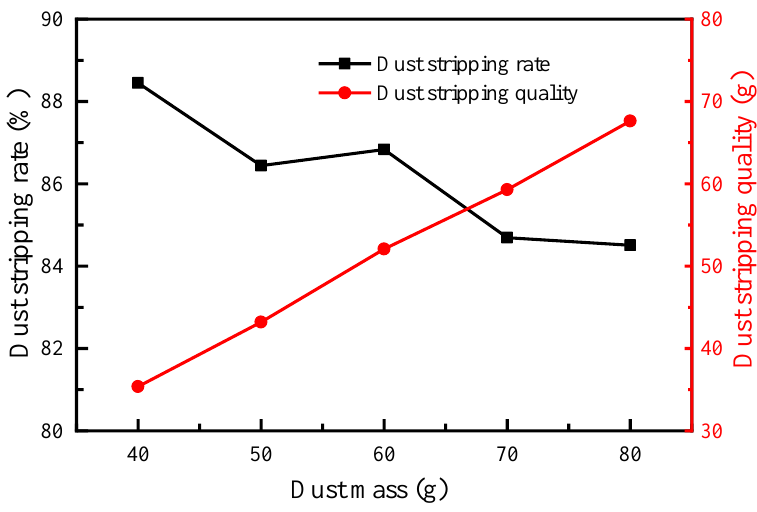
Figure 8. The effect of dust quality on dust stripping rate (DSR).